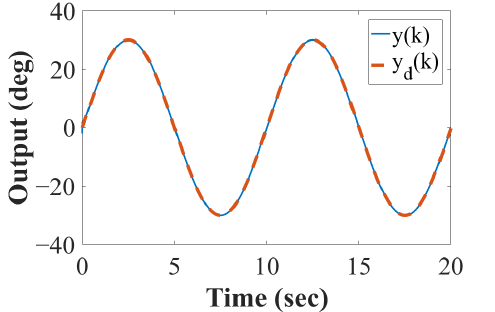
Figure 7. Output signals of the simulation in group 1 (proposed method).